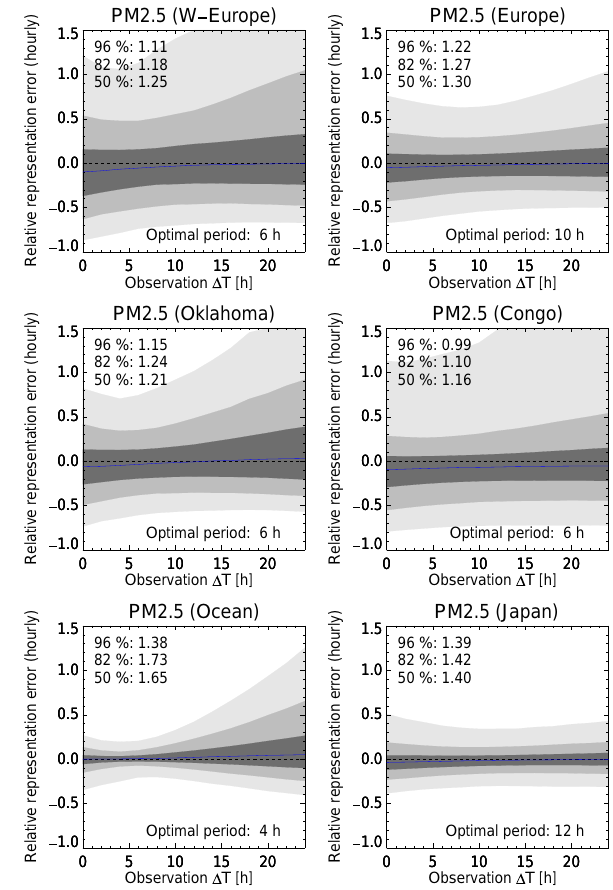
Figure 21. Daily representation errors as a function of averaging period (cid:49)T used for surface PM 2 . 5 observations. In the top-left cor- ner of each panel, the ratios of q 98 – q 2 , q 91 – q 9 and q 75 – q 25 for (cid:49)T = 0 to optimal (cid:49)T are given. Results for a 210 × 210km 2 grid box. Further explanation in Sect. 3.2.